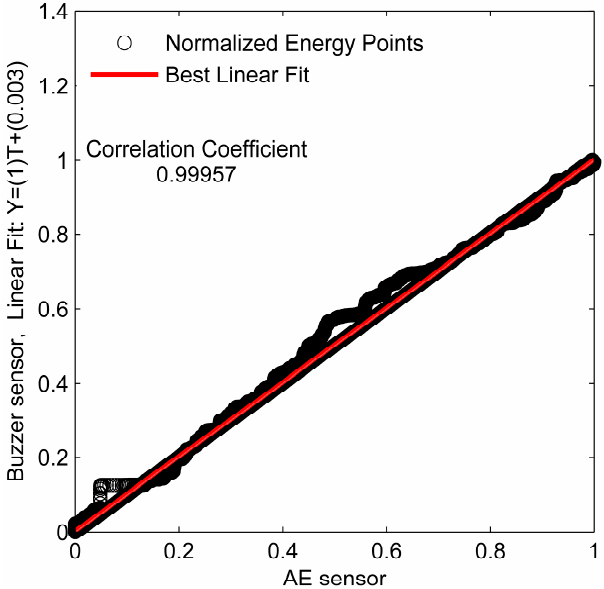
Figure 9. Linear fit and correlation coefficient for the energy.